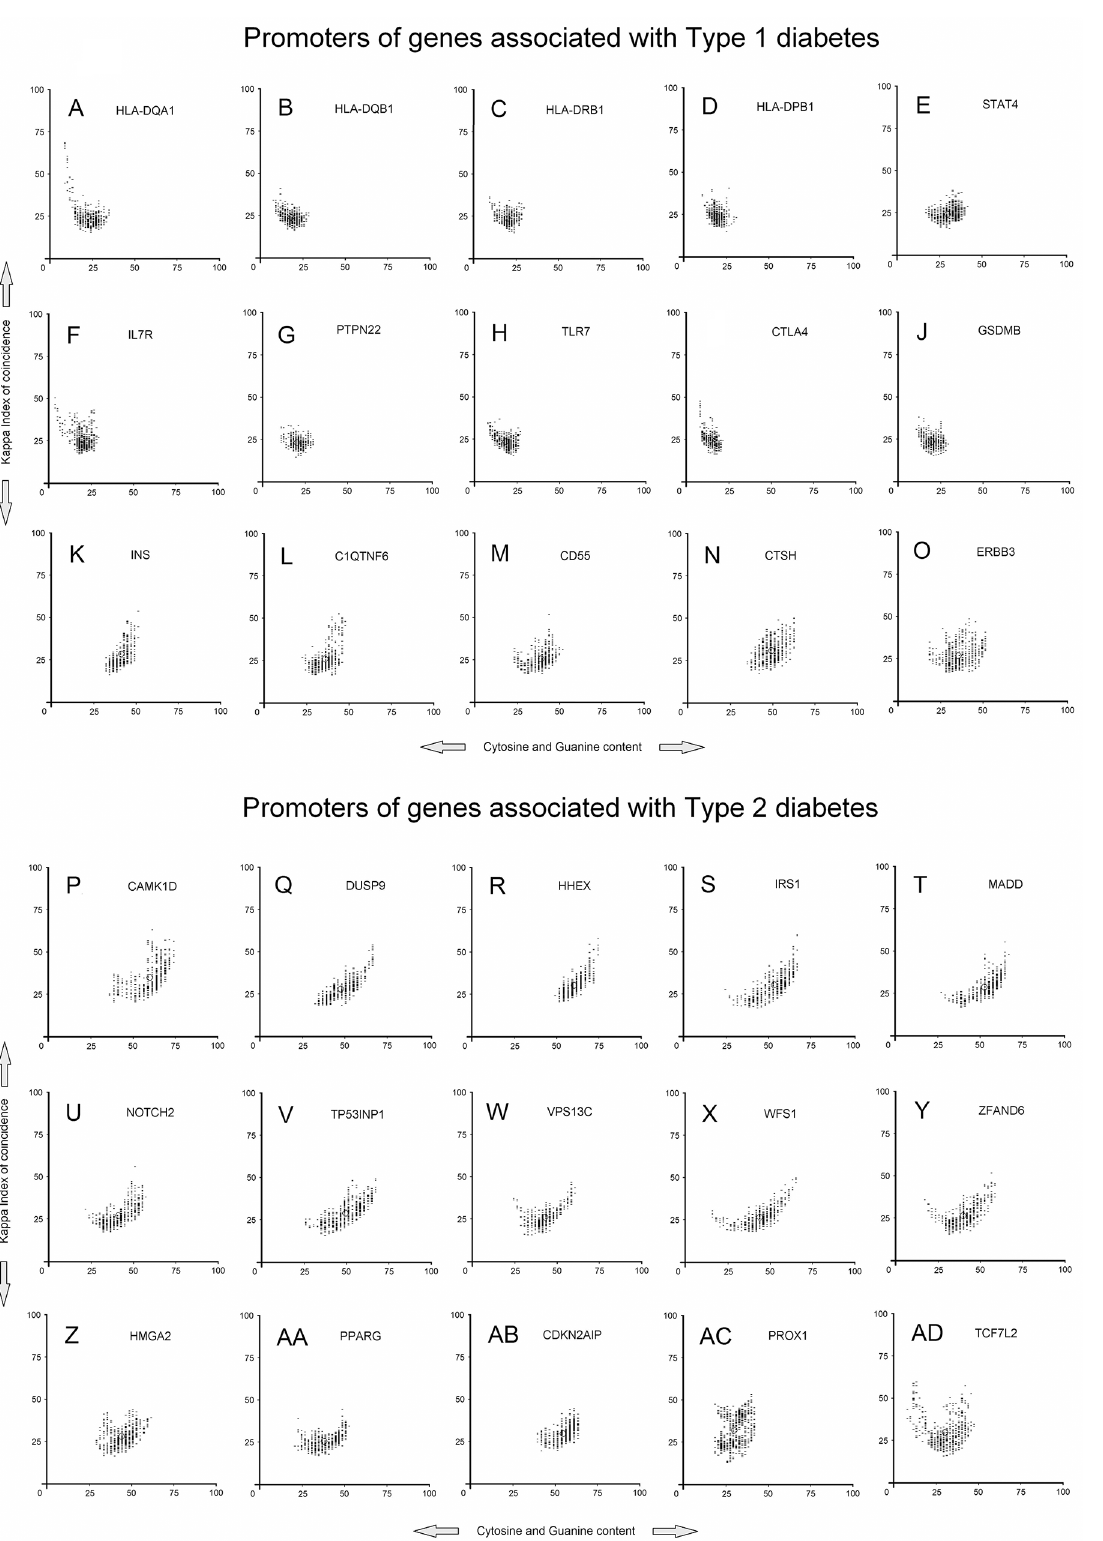
Fig 1. Image-based promoter patterns of genes classically associated with T1D and T2D. (A-O) promoters of genes associated with T1D, (P-AD) promoters of genes associated with T2D. Each black circle represents the center of weight of the promoter pattern. doi:10.1371/journal.pone.0137950.g001 PLOS ONE | DOI:10.1371/journal.pone.0137950 September 17,